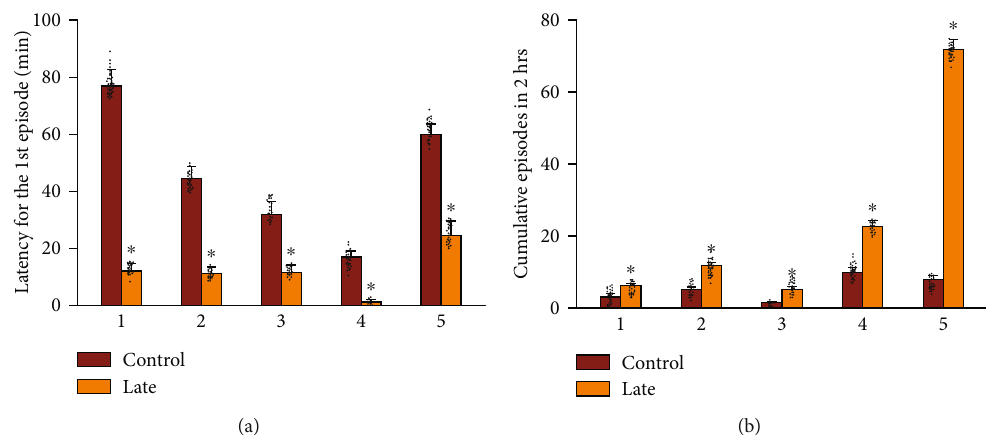
Figure 2: Observations of opioid-withdrawal behaviors in rat o ff spring on P14. (a) The rat o ff spring which were observed for 2h starting from the 6th hour after transfer (the late group) exhibited shorter latency in exhibiting opioid-withdrawal behaviors. (b) There were more opioid-withdrawal behaviors in a 2 h period in the late group. 1: rearing; 2: teeth chattering; 3: backward locomotion; 4: tremor; 5: wet-dog shaking. Each group was derived from independent 48 rats, respectively. ∗ p < 0 : 05 , compared to the control group.